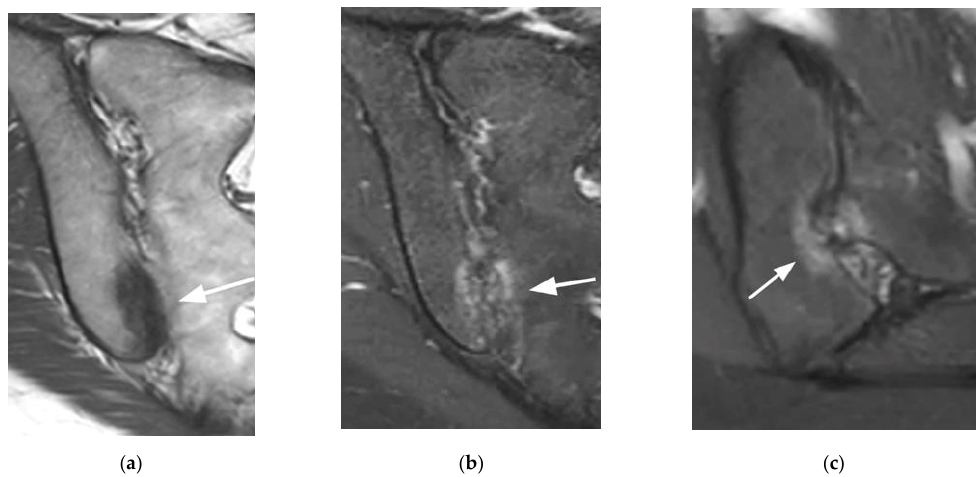
Figure 6. Dysmorphic SIJ (coronal oblique T1- ( a ) and fat-suppressed T2- ( b ) weighted images, axial oblique fat-suppressed T2- ( c ) weighted image). Edematous and sclerotic changes of the distal third of the SIJ mimicking sacroiliitis on the coronal images (arrow). On the axial oblique image, these features are focal, limited in size, and centered by the dysmorphic joint in the posterior part of the cartilaginous joint (arrow).